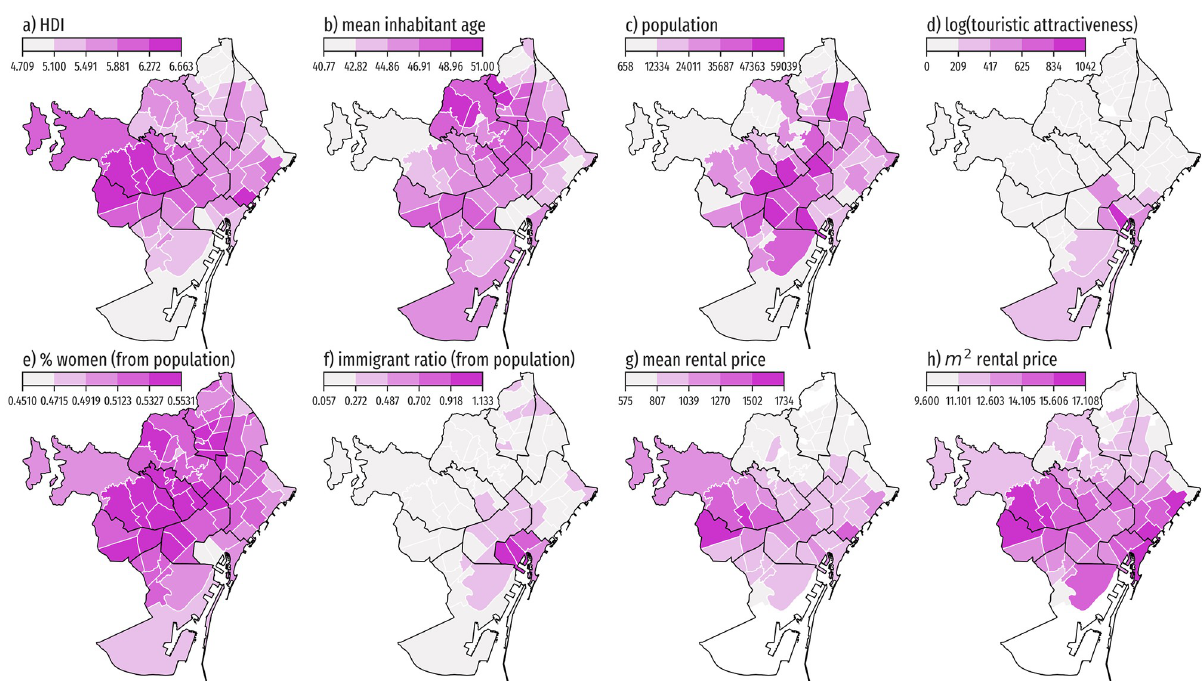
Fig 1. City data for the neighborhoods of Barcelona. Choropleth maps of neighborhood features in Barcelona. a) Mean socio-economic characterization, Human Development Index (HDI; unitless, from 0 to 10). b) Mean age (years). c) Resident population count. d) Touristic attractiveness. e) Population percentage registered as women. f) Ratio between immigrants and nationals. g) Mean rental price in Euros. h) Mean rental price per square meter in Euros. Administrative boundaries are sourced from CartoBCN under a CC BY 4.0 license, with permission from Ajuntament de Barcelona , original copyright